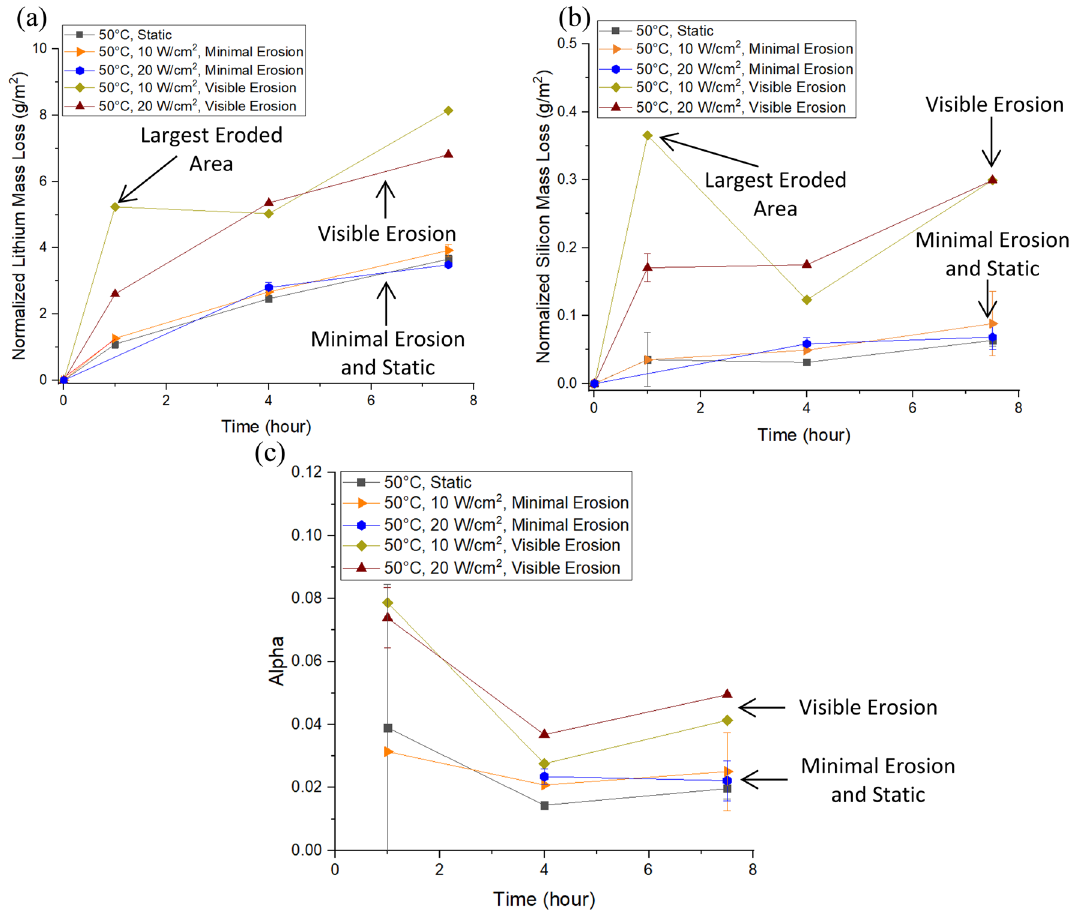
Figure 7. Lithium normalized mass loss ( a ), silicon normalized mass loss ( b ), and alpha value ( c ) plots for ultrasonic experiments created using OriginPro. Static experiments are included for comparison. Results show that samples with any amount of visible erosion have a ~ 2–3 × increase in dissolution compared to samples from other experiments. The experiment with the sample that produced the largest Type 3 surface also has a much higher amount of dissolution compared to other data points from the same time frame. This could indicate the potential change in dissolution due to cavitation under optimal